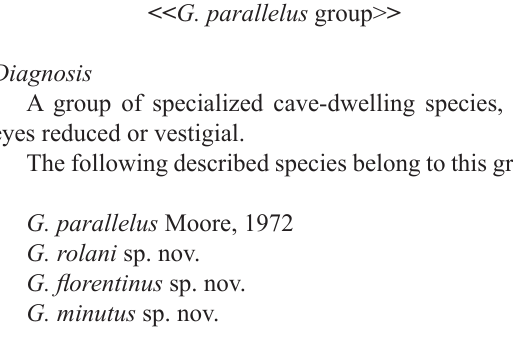
Diagnosis a Goedetrechus of the parallelus group, character- ized by the small size (4.13 mm) and the relatively poorly elongated pronotum, similar in this to G. parallelus . It